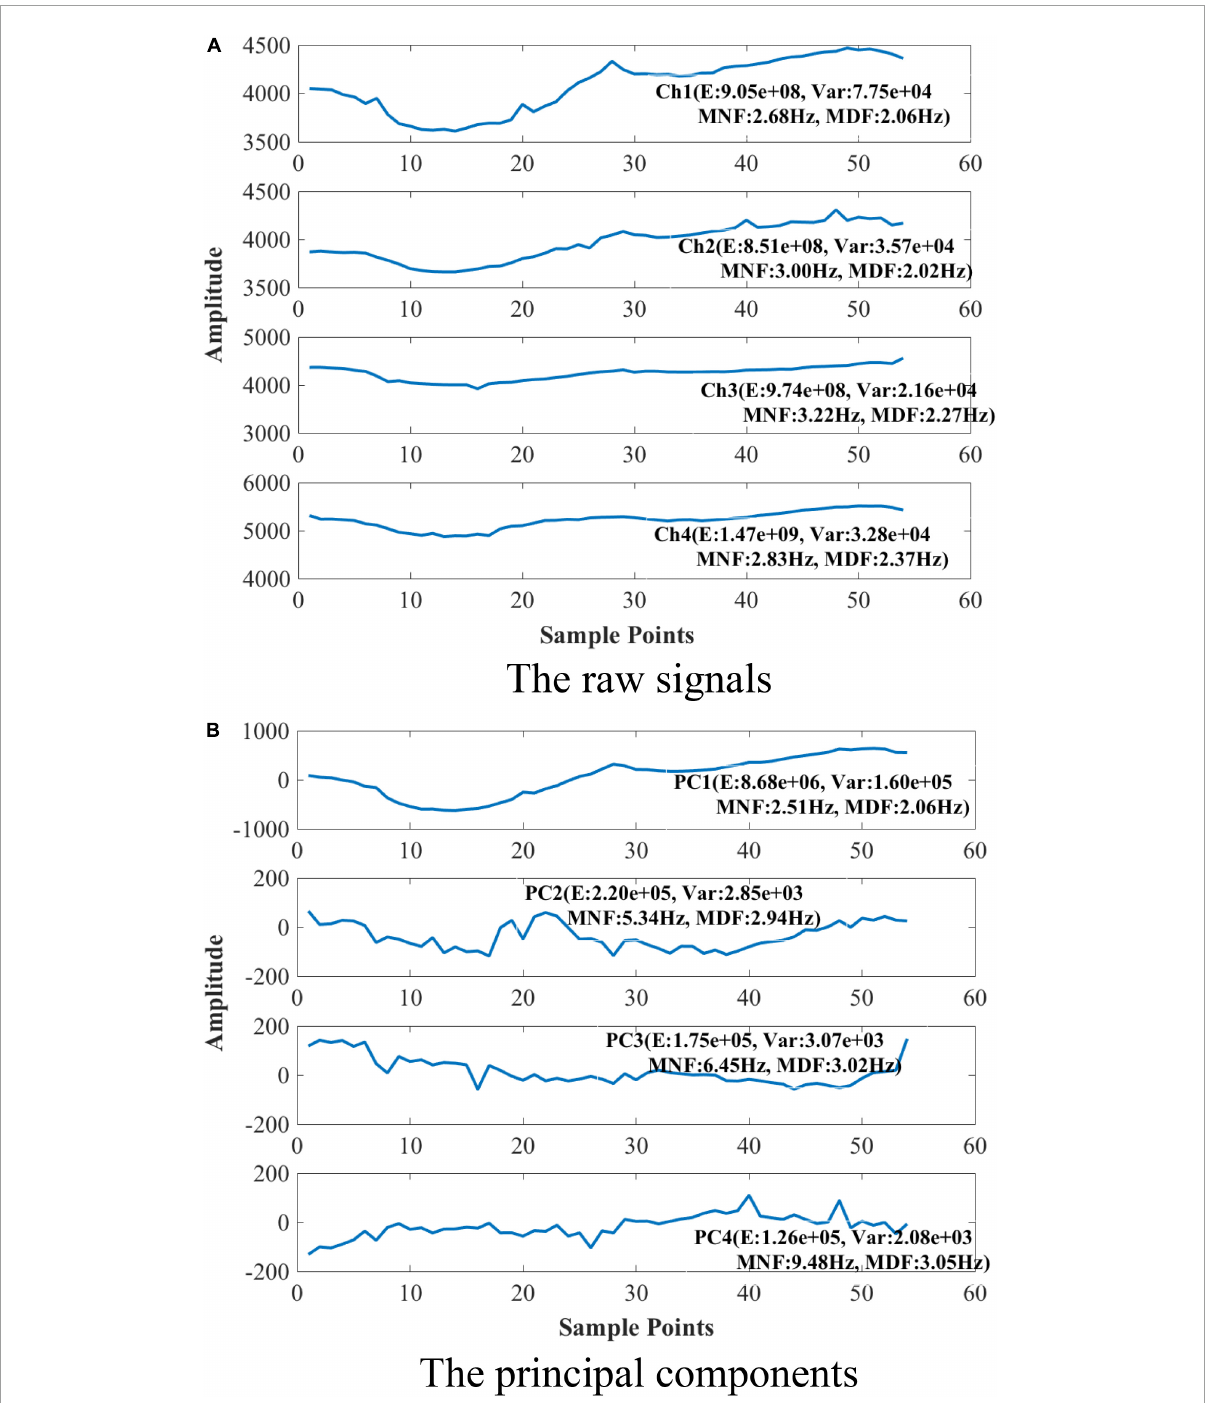
FIGURE4 Raw signals and PCA decomposition results of a green light PPG sample (PC, principal component; E, energy; Var, variance; MNF, mean frequency; MDF, median frequency). (A) The raw signals. (B) The principal components.